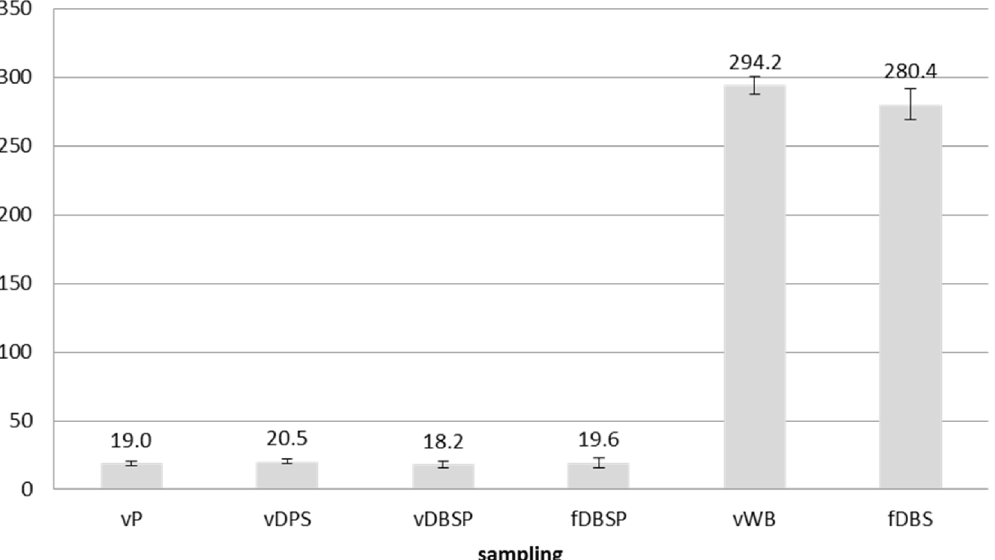
Fig 5. Comparison of the developed dried matrix spot methods with conventional sampling procedures. vP plasma sample from venous blood, vDPS dried plasma spot from venous blood, vDBSP dried blood spot with plasma folate determination from venous blood, fDBSP dried blood spot with plasma folate determination from finger blood, vWB whole blood sample from venous blood, fDBS dried blood spot from finger blood.